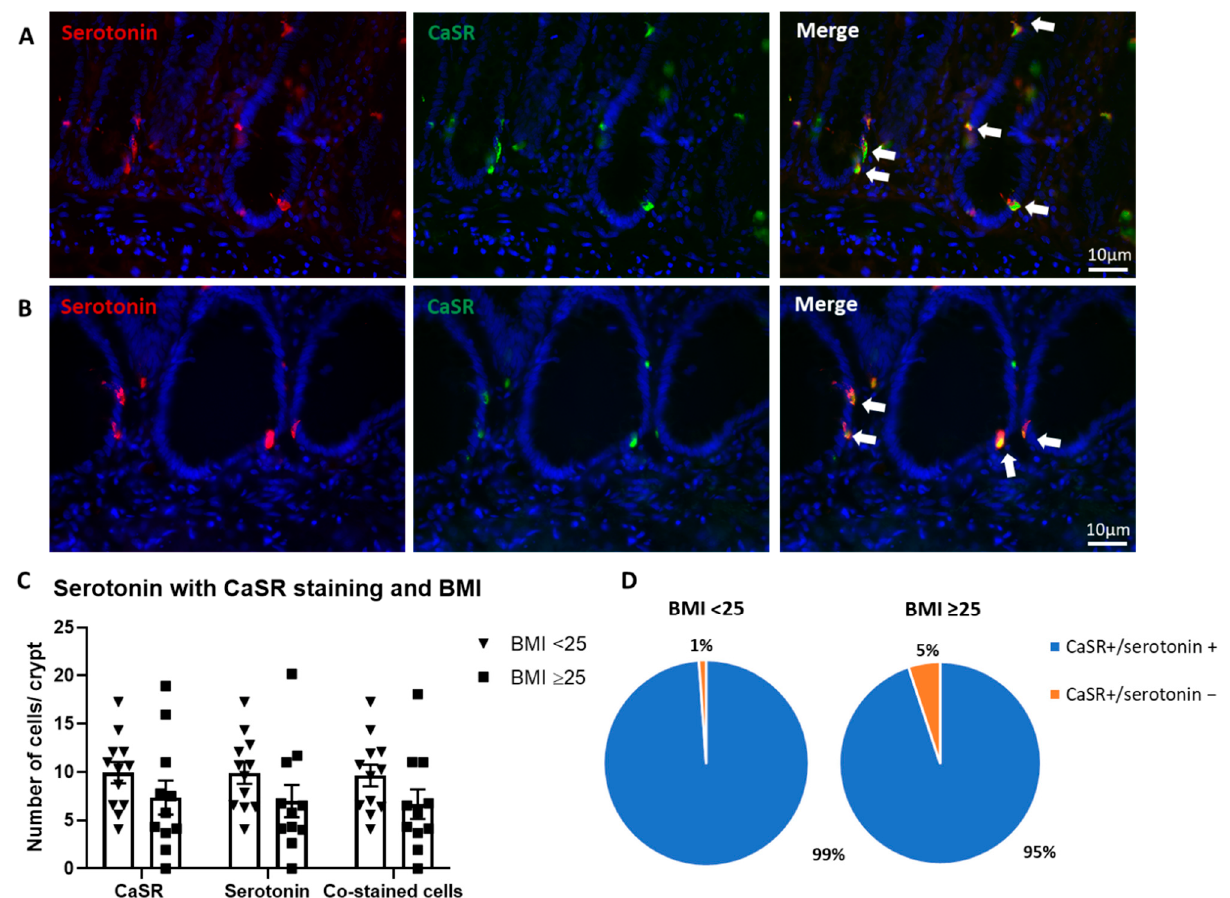
Figure 5. Serotonin and CaSR expression in human colonic samples according to BMI. ( A ): Representative image from BMI < 25 patient tissue staining for serotonin (red) and CaSR (green). ( B ): Representative image BMI ≥ 25 patient tissue staining for serotonin (red) and CaSR (green). Arrows denote serotonin and CaSR co-stained cells. ( C ): Quantification of positive cells per crypt for CaSR, serotonin and co-stained cells in BMI < 25 ( n = 12) and BMI of ≥ 25 ( n = 11). ( D ): Proportion of cells per crypt CaSR+/serotonin+ or CaSR+/serotonin- in patients with a BMI < 25 and BMI ≥ 25. Scale bars represent 10 µ m.